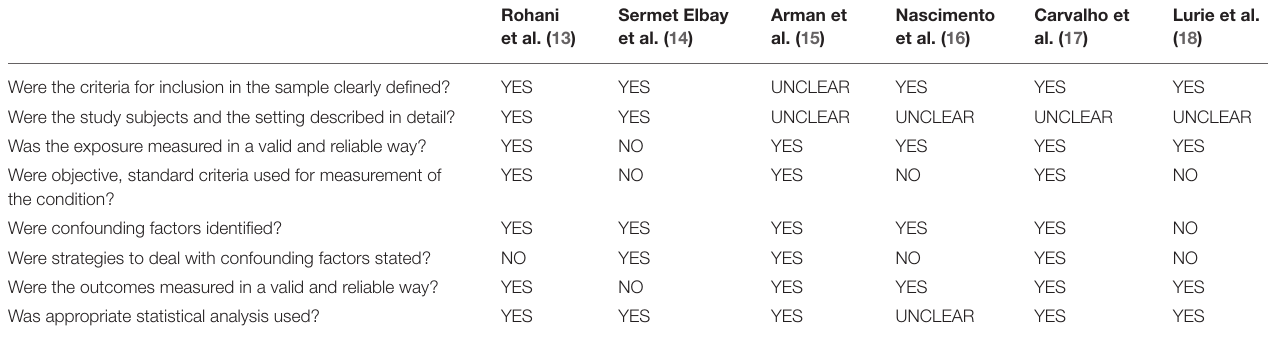
TABLE 2 | Quality assessment and risk of bias according to Critical Appraisal Tool (Joanna Briggs Institute, 2017).